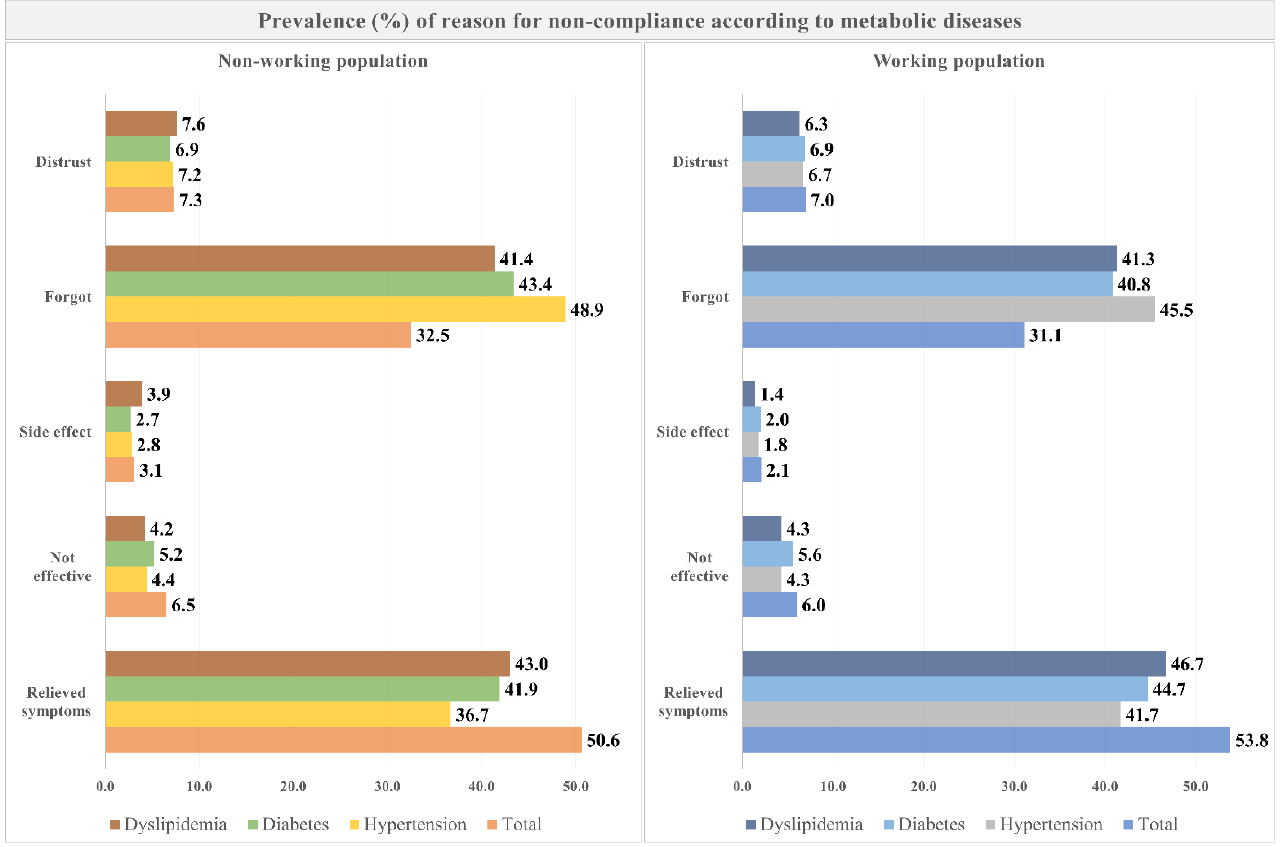
Figure 3. Prevalence of reasons for noncompliance with medication according to metabolic diseases.